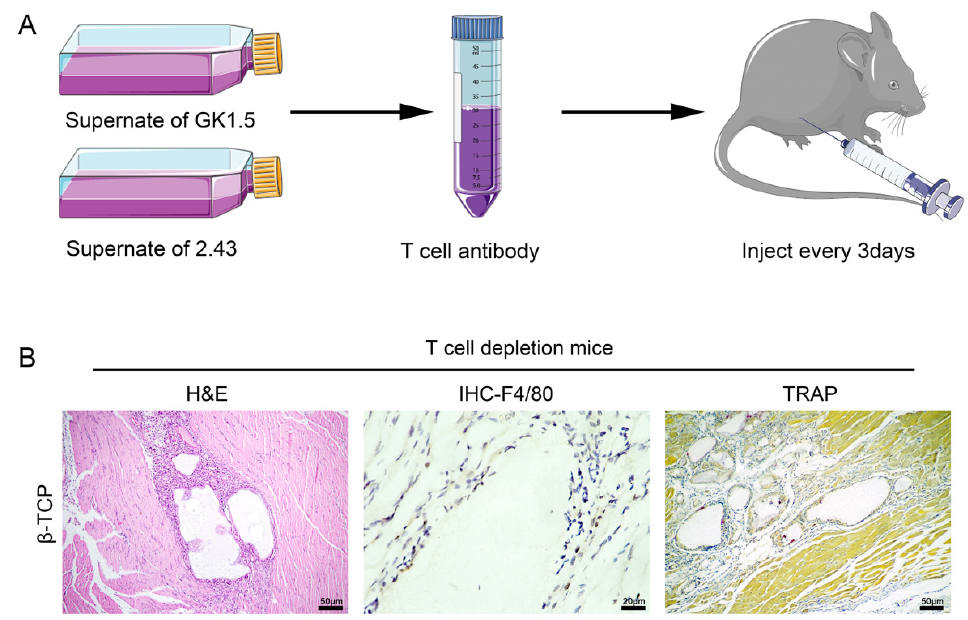
Figure 4. T-cell depletion interferes with the FBGC-mediated biodegradation of β -TCP. ( A ) Schematic Figure 4. T ‐ cell depletion interferes with the FBGC ‐ mediated biodegradation of β‐ TCP. ( A ) Sche ‐ diagram of T-cell depletion in an animal model. ( B ) H and E, IHC-F4/80, and TRAP staining showed matic diagram of T ‐ cell depletion in an animal model. ( B ) H and E, IHC ‐ F4/80, and TRAP staining the FBGC-mediated biodegradation of β -TCP in T-cell depletion in showed the FBGC ‐ mediated biodegradation of β‐ TCP in T ‐ cell depletion in mice.